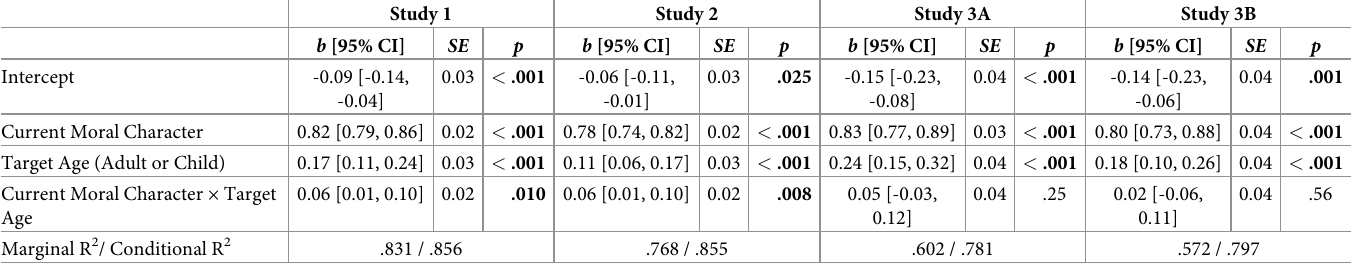
Table 1. Forecasts about future moral character predicted by (a) inferences about current moral character, (b) target age (adult or child), and (c) the interaction between current moral character and target